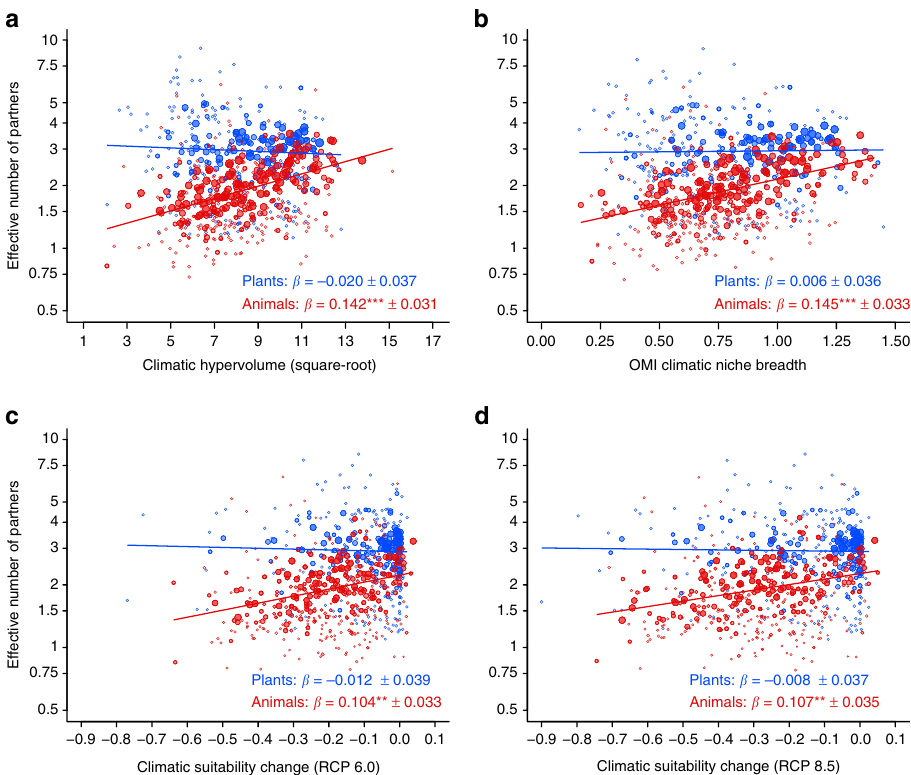
Figure 1 | Biotic specialization in relation to climatic niche breadth and vulnerability to climate change. Associations of ( a , b ) realized climatic niche breadth (climatic hypervolume 60 , OMI climatic niche breadth 61 ) and ( c , d ) projected climatic suitability change (RCP 6.0, RCP 8.5 scenarios 65 ; year 2070) with the effective number of partners ( e H ) of plant ( n ¼ 295) and animal ( n ¼ 414) species in 13 mutualistic interaction networks from central Europe. Specialization is the effective number of interaction partners 66 of plant (blue) and animal (red) species in each network (shown on a log-scale). Trend lines indicate the estimated slope ( b ) in a mixed-effects model accounting for effects of network identity and animal and plant taxonomy on model intercepts. Shown are species’ mean partial residuals plus intercept from these models; symbol size is proportional to the weight of each species in the analysis, corresponding to its number of occurrences across networks and, in the case of climatic suitability change, the accuracy of the species distribution model (TSS max value 64 ); given are slope estimates ± 1 s.e. for plants and animals, P values were derived by Kenward–Roger approximation: ** P o 0.01 and *** P o 0.001 (for full statistics see Supplementary Table